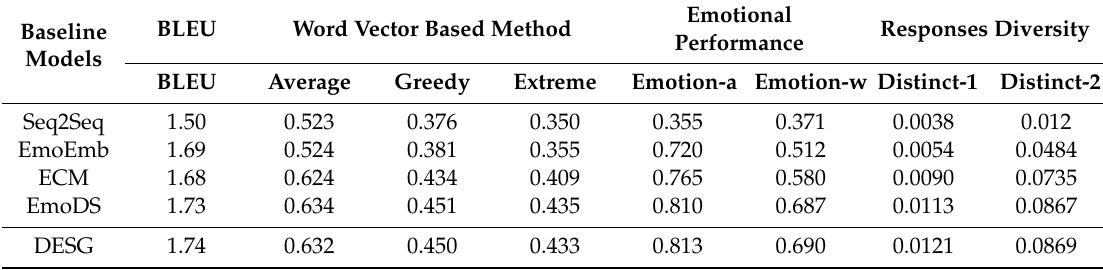
Table 4. Comparisons with